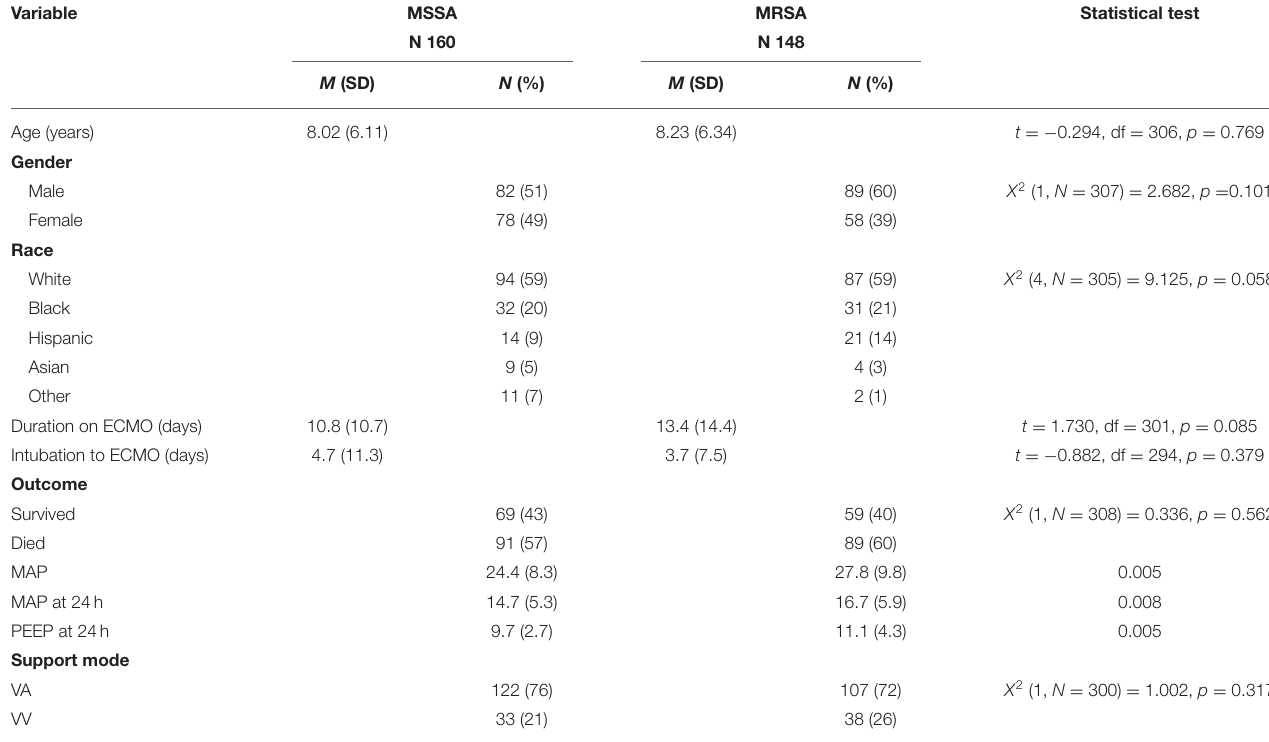
TABLE 1 | Characteristics of children receiving ECMO due to MSSA or MRSA sepsis.